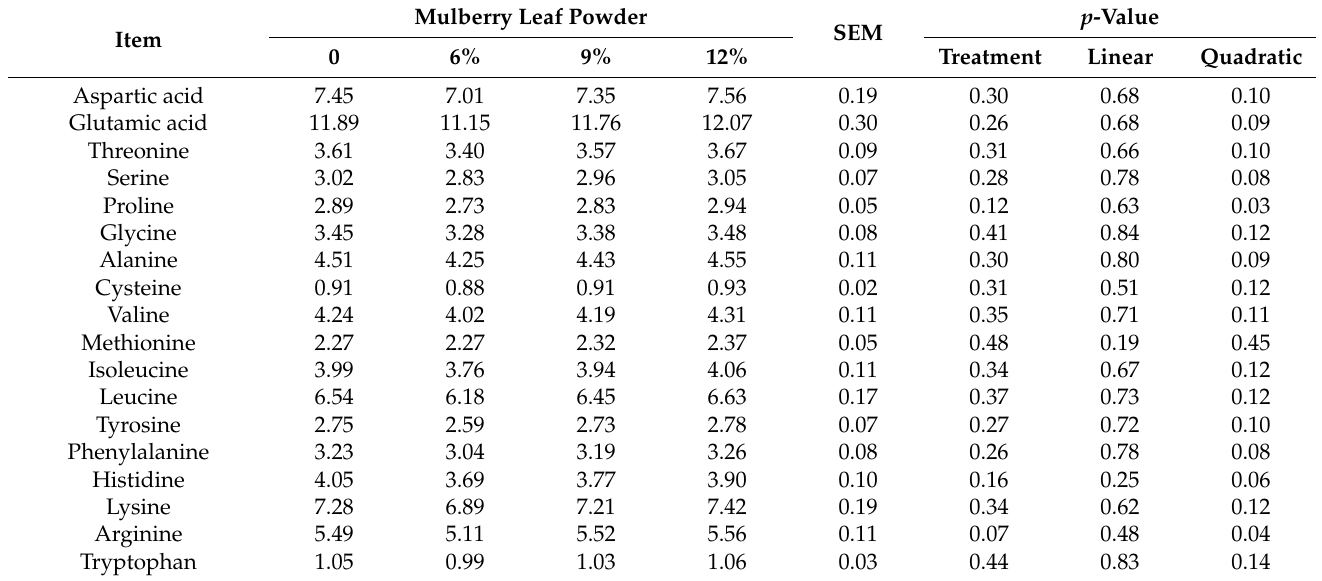
Table 6. Effect of mulberry leaf powder of varying levels on concentration of muscle amino acid in finishing pigs